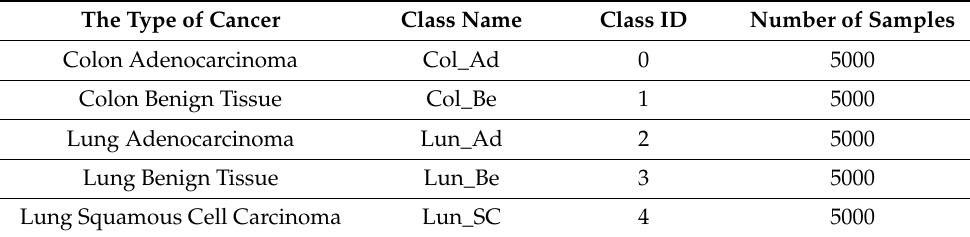
Figure 1. Sample images of ( a ) colon adenocarcinoma, ( b ) colon benign tissue, ( c ) lung adenocarcinoma, ( d ) lung benign tissue, and ( e ) lung squamous cell carcinoma collected from the LC25000 dataset. Table 1. Contents of the LC25000 dataset and the assigned class